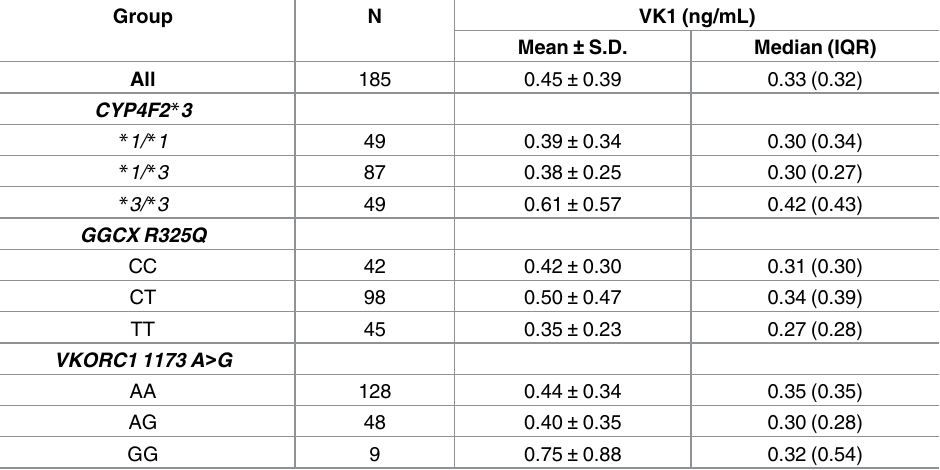
Table 3. Relationship between plasma VK1 and CYP4F2 , GGCX , and VKORC1 genotypes.